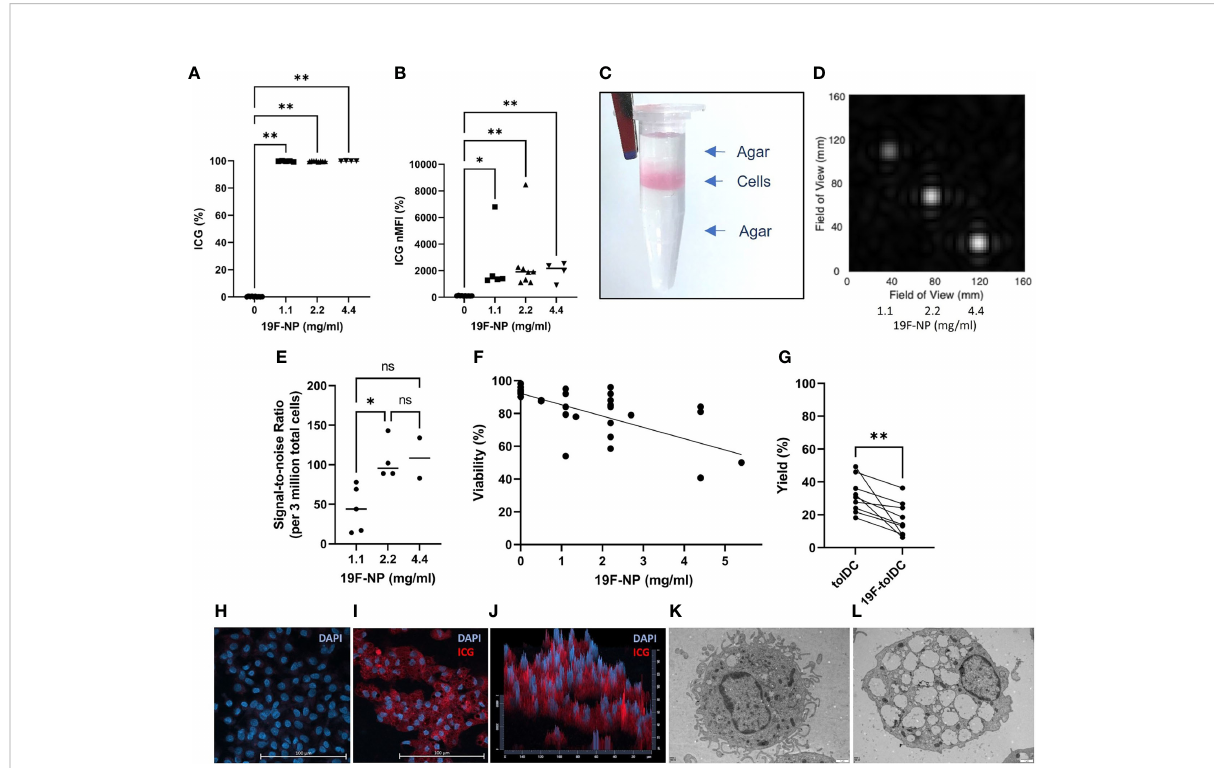
FIGURE 1 Uptake of 19 F-NP by tolDC. 19 F-NP (0-5.4 mg/ml) was added to tolDC for the last 20-24 hours of culture, after which cells were harvested, washed and counted. Uptake of 19 F-NP was determined by fl ow cytometry, data are shown as (A) percentage of cells positive for the ICG label and (B) as normalised median fl uorescent intensity (nMFI) by dividing the MFI obtained for 19 F-tolDC by the MFI obtained for unlabelled tolDC then multiplied by 100. 19 F-tolDC were incorporated into an agar phantom (C) for detection by MRI at 3 concentrations of 19 F incubation. Left to right; 1.1 mg/ml, 2.2 mg/ml and 4.4 mg/ml; scan time 23 mins 0 secs (D, E) data are depicted as the signal-to-noise ratio per 3 million tolDC. (F) Viability of tolDC was determined by fl ow cytometry using Zombie Aqua and (G) tolDC yield calculated as a percentage of the monocytes seeded on day 0. tolDC were cultured on glass slips and incubated with and without 2.2 mg/ml 19F PLGA for 20-24 hours. The glass slips were washed and stained with DAPI (blue) to indicate nuclei. tolDC on the slips were imaged using confocal microscopy. Nuclei (blue) were detected in unlabelled tolDC (H) whilst nuclei (blue) and 19 F-NP (red) were detected in the 19 F-tolDC (I) . The 19 F-NP is localised to the cytoplasm of the cells and is present throughout the cytoplasm as visualised in the pseudo 3D plot (J) . TEM images of tolDC (K) and 19 F-tolDC (L) show distinct endocytic structures present in the cytoplasm of the 19F-tolDC. Graphs (A, B, E) show individual values with the median as a line (*p ≤ 0.05, **p ≤ 0.01). Graph (F) displays individual values with a line of regression. Spearman ’ s Rank Correlation Coef fi cient was performed on the samples and r found to be -0.6870 with a p-value<0.0001. Graph (G) displays paired values connected by a line (**p ≤ 0.01). NS, not signi fi